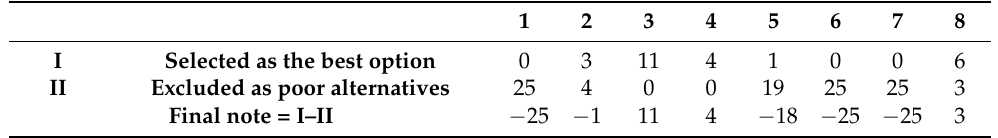
Figure 2. Variants 1 – 8 presented to the participants of the preliminary experiment. Eight examples differ in the luminance of the additions.. Table 1. Answers given by the participants in the preliminary experiment.